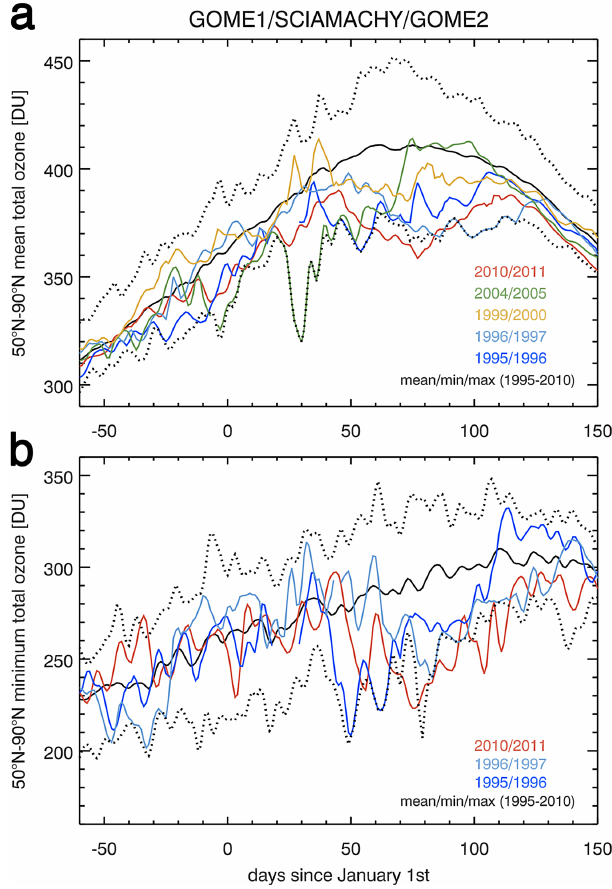
Fig. 2. Evolution of Arctic total ozone in the GSG data set for various cold winters with severe ozone losses since 1995. (a) area weighted mean and (b) the minimum total ozone as obtained from the GSG data set north of 50 ◦ N. Coloured lines show time-series of individual Arctic winters as indicated. The solid black line is the mean of all years in the 16 year data record (1995–2010). The dot- ted line shows the maximum and minimum value observed during the entire data